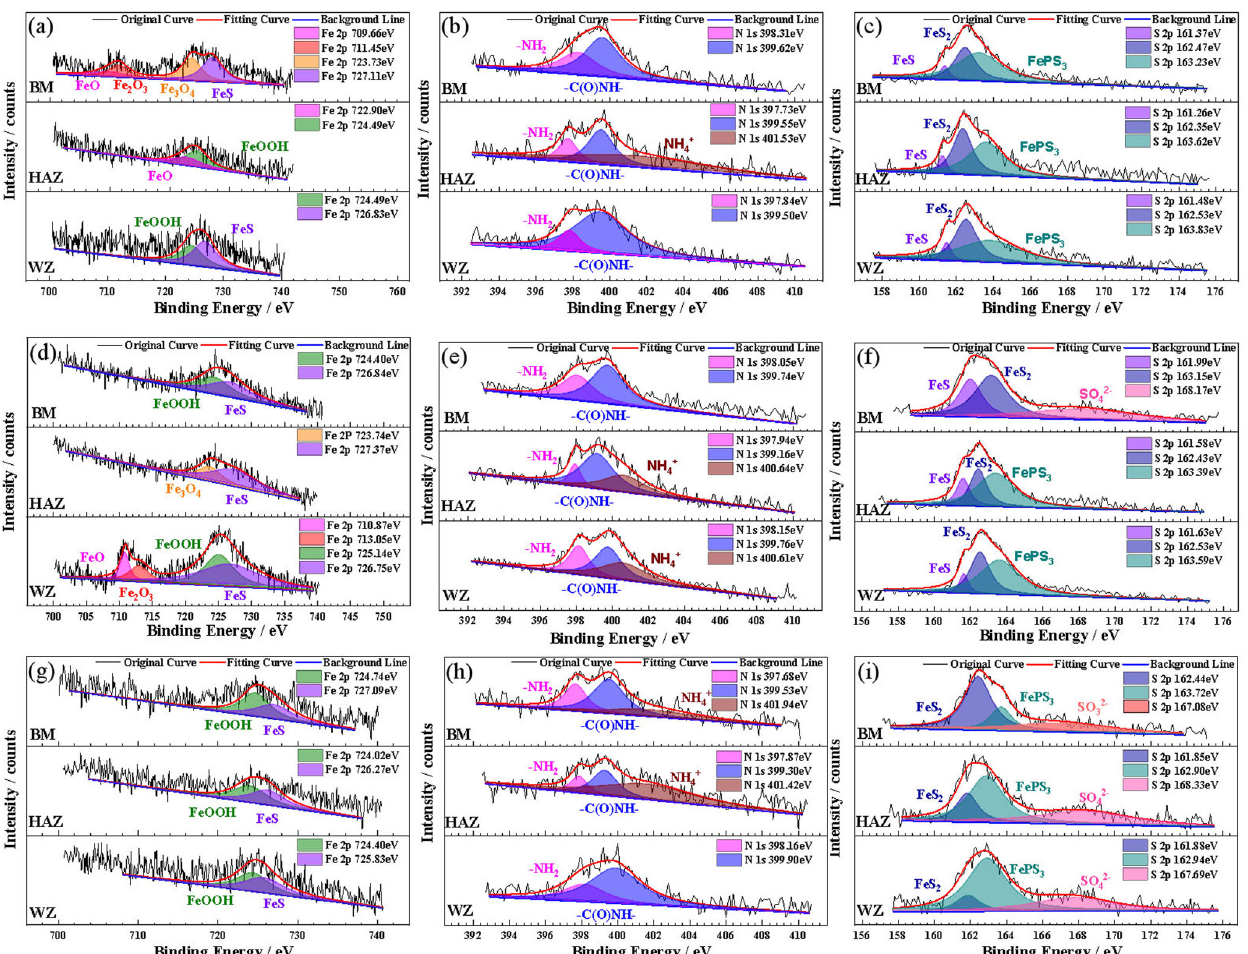
Fig. 4 XPS spectra of corrosion products on welded joints after 30 d immersion. a – c Show the XPS spectra of corrosion products on the welded joints in the medium with 0% organic carbon sources level. d – f Show the XPS spectra of corrosion products on the welded joints in the medium with 1% organic carbon sources level. g – i Show the XPS spectra of corrosion products on the welded joints in the medium with 100% organic carbon sources